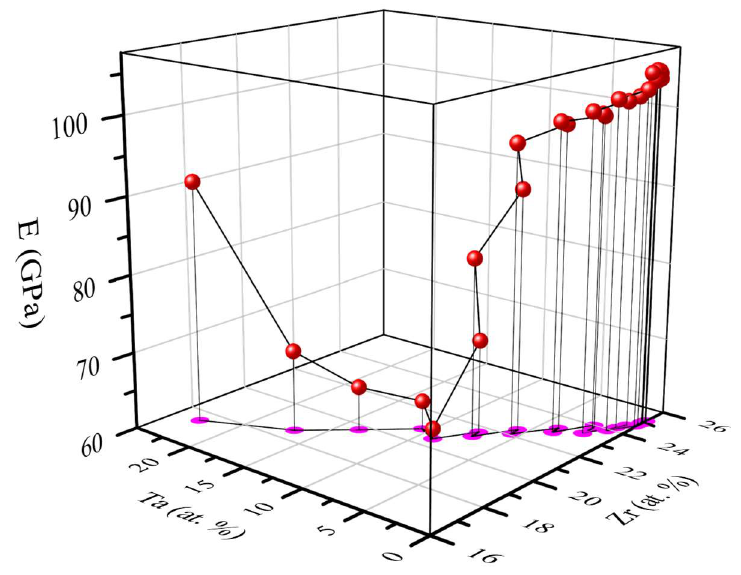
Figure 4. Elastic modulus vs. composition of the TiZrTa alloys. The pink dots are the projection of elastic modulus data on the Zr-Ta alloying composition plane.